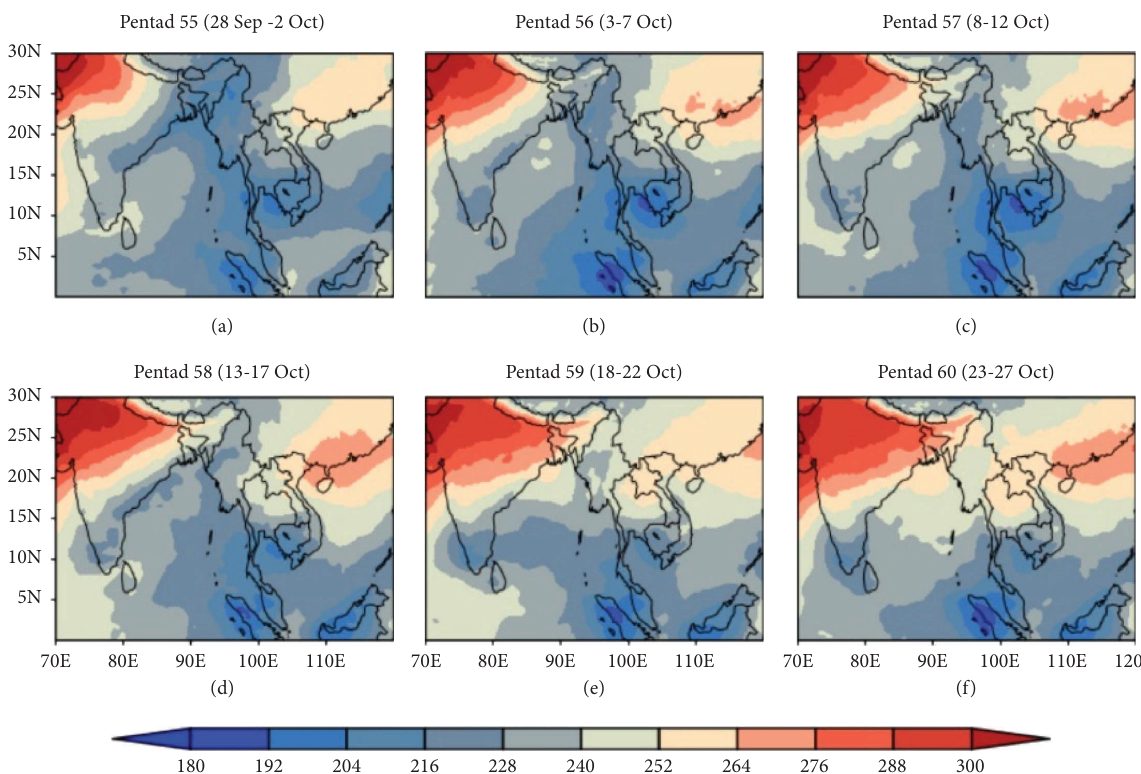
Figure 20: Composite of Climatology (1991–2020) OLR (W m − 2 , colour) during the pentads (a) P -55 (Sep 28–Oct 2), (b) P -56 (Oct 3–7), (c) P -57 (Oct 8–12), (d) P -58 (Oct 13–17), (e) P -59 (Oct 18–22), and (f) P -60 (Oct 23–27) during the monsoon withdrawal